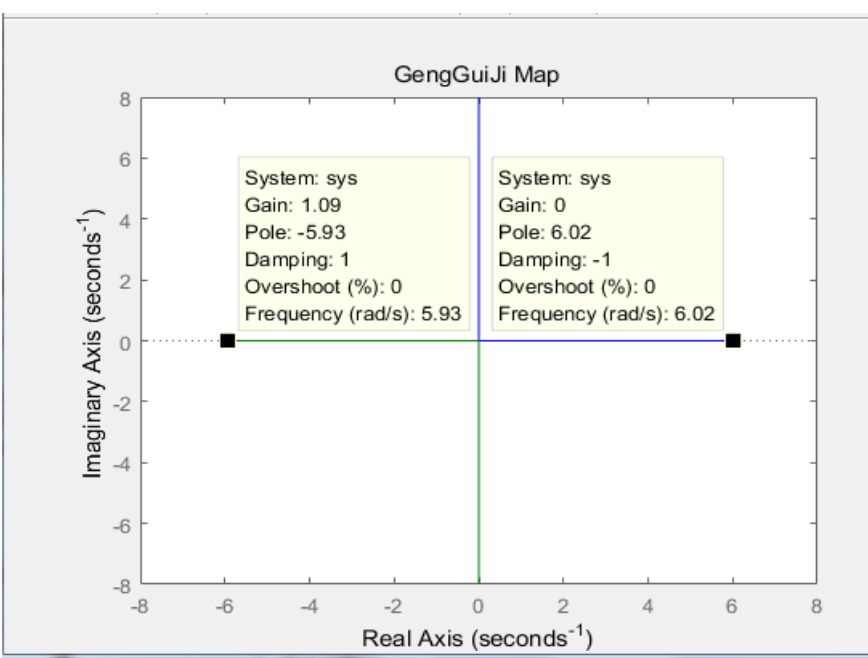
Figure 7. The original root locus of the robot.